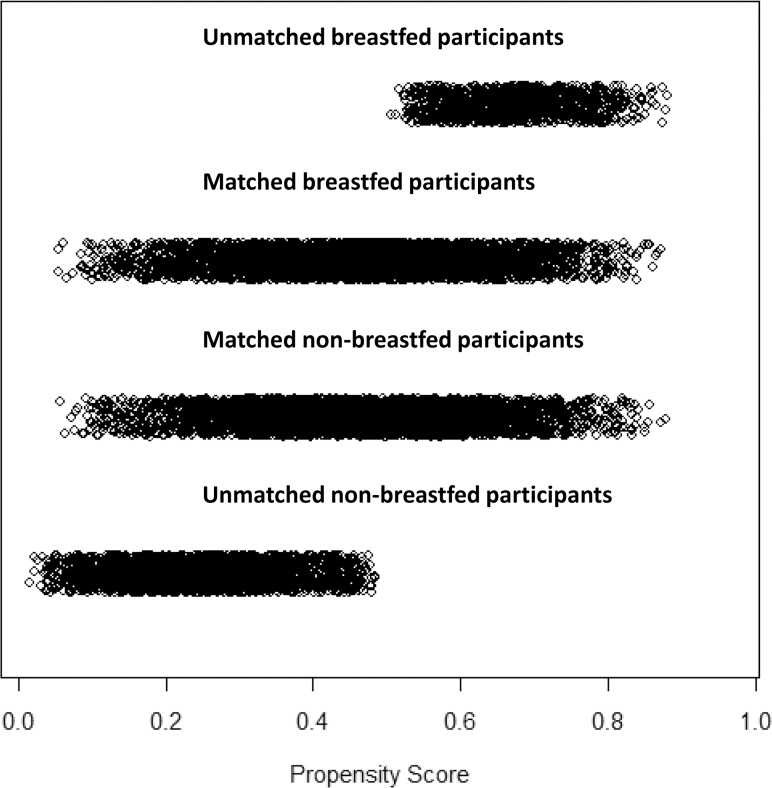
Distribution of propensity scores in matched and unmatched groups.Distribution of propensity scores of study participants in the breastfed and non-breastfed groups who could be matched and remained in the dataset and of those who could not be matched and were removed.